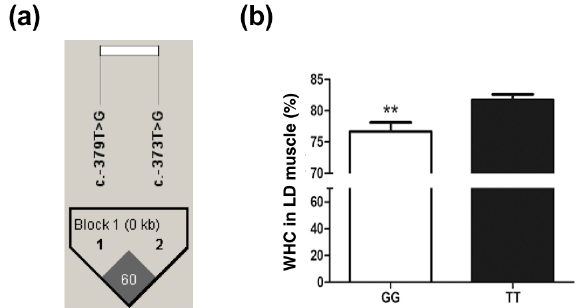
Figure 3. The WHC of longissimus dorsi muscle in pigs with GG and TT genotypes at ca. − 373T > G in UBXN1 . (a) Linkage dis- equilibrium analysis for SNPs ca. − 379T > G and ca. − 373T > G are based on r 2 measurement. (b) The WHC (%) of porcine longis- simus dorsi muscle in GG ( n = 48) and TT ( n = 53) genotypes. The data shown in figures are arithmetic means ± standard error of the mean (SEM). ∗∗ P< 0 .